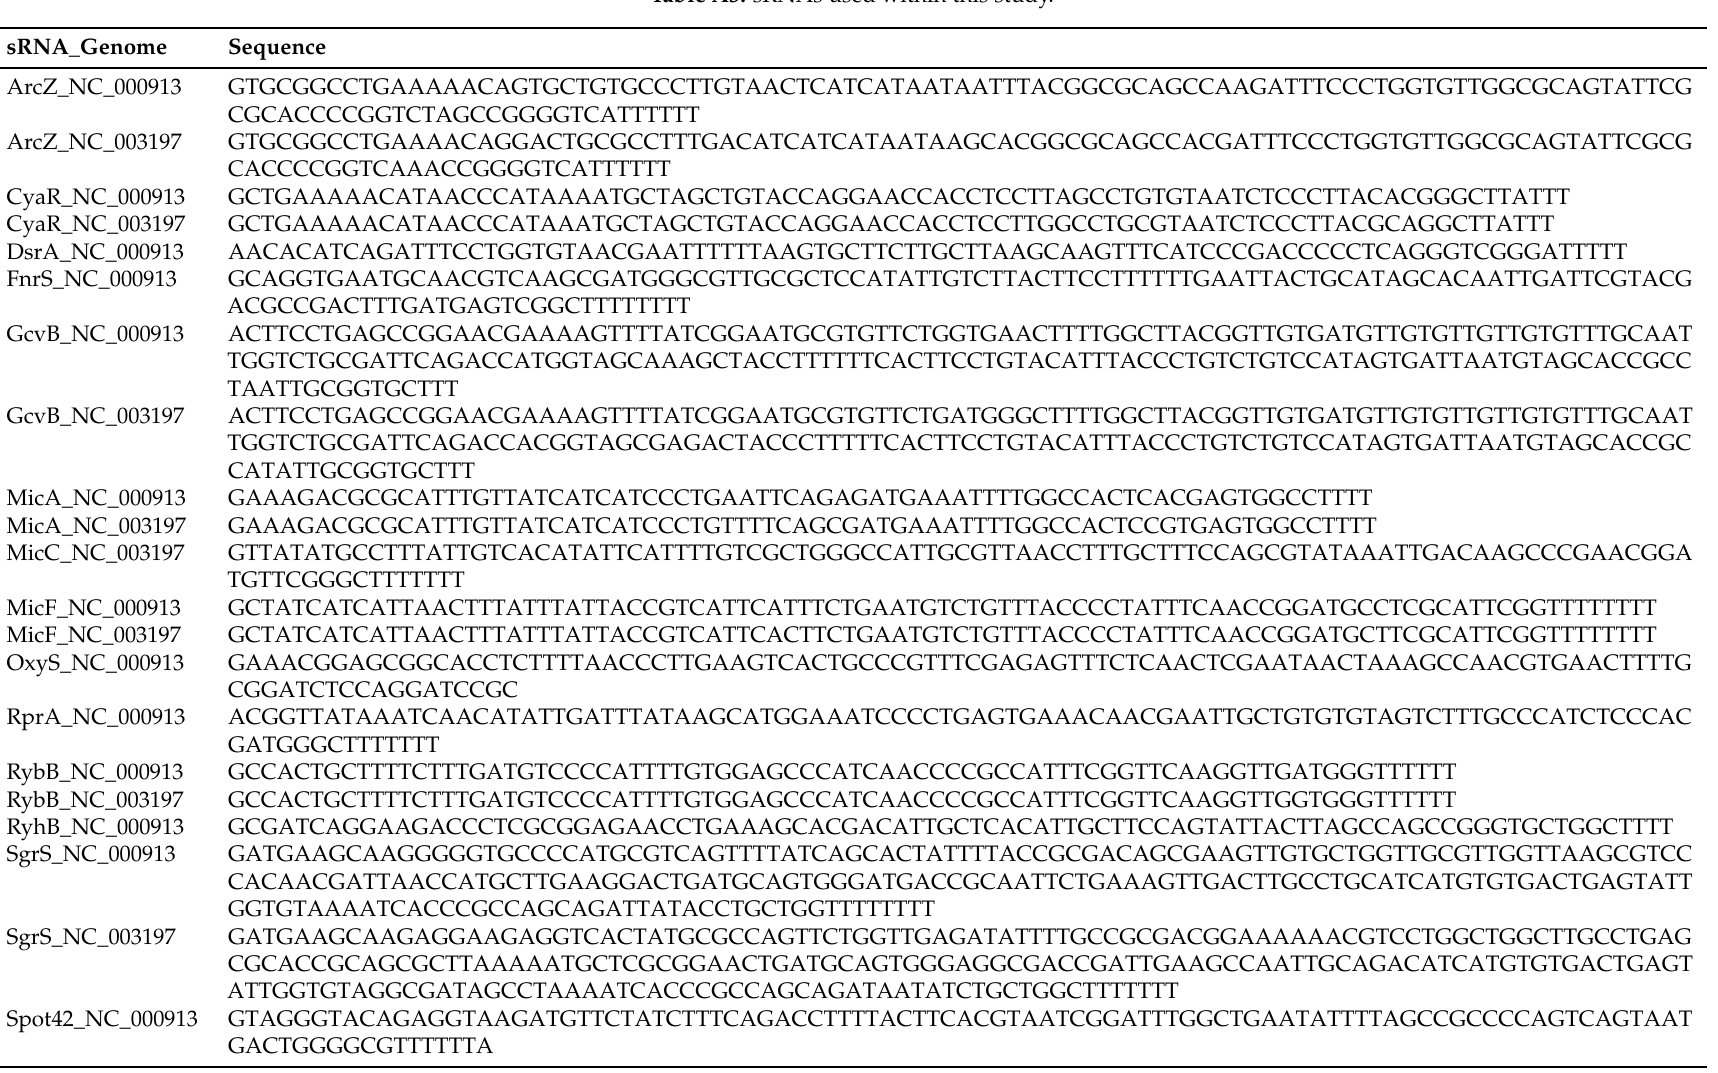
Table A3. sRNAs used within this